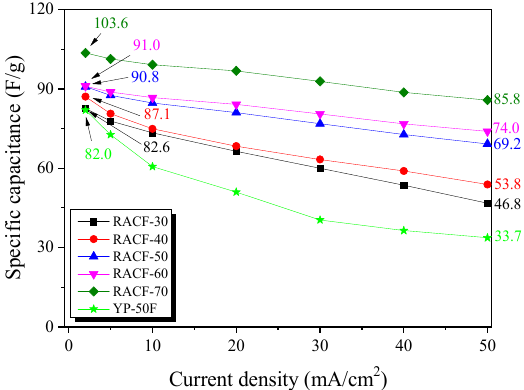
Figure 7. Specific capacitance of RACF as a function of discharge current density.